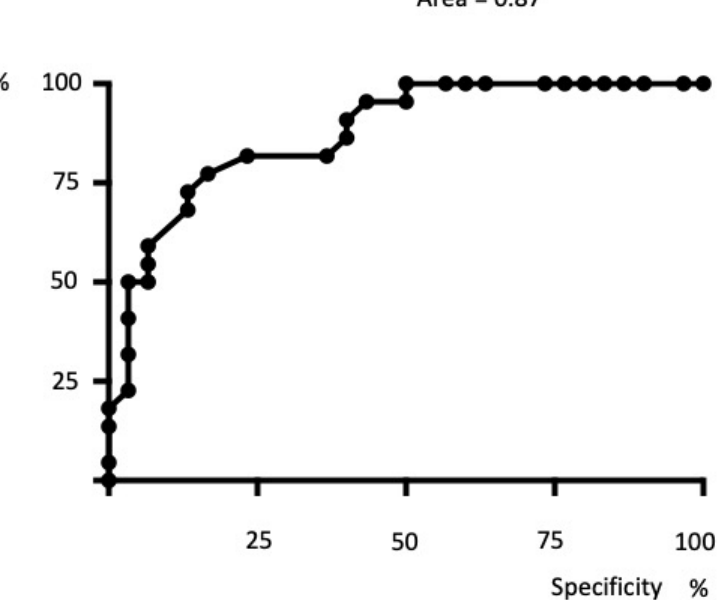
Figure 5. Receiver operating characteristic (ROC) curves and area under the receiver operating characteristic (AUROC) values. The ROC curve shows the trade-off between sensitivity (the true positive rate) and specificity (the false positive rate). Better ratio sensitivity/specificity was obtained for a cutoff value of the 72.5% inhibition in the novel ELISA. The area under the curve was well over 50% (0.87); therefore, the test can be considered to have good